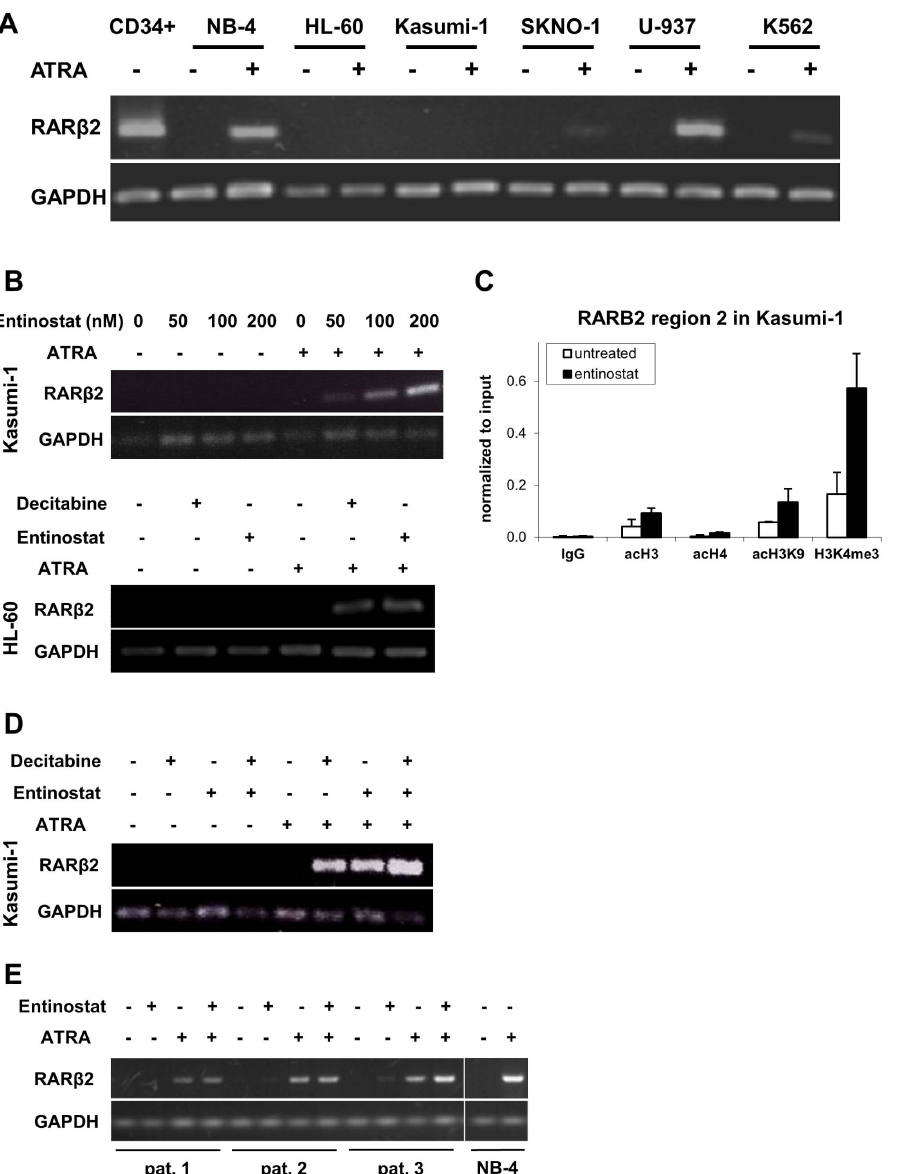
Figure 3. Epigenetic RAR b 2 gene silencing in myeloid leukemia cells is reversed by epigenetically active drugs. ( A ) The AML cell lines NB-4, HL-60, Kasumi-1, SKNO-1 and U-937 as well as the CML cell line K562 were treated with 1 m M ATRA for 72 hours, and expression of RAR b 2 was determined by RT-PCR. The expected band of 621 bp corresponding to the RAR b 2 isoform is shown. Normal CD34 + cells were used as a positive control for RAR b 2 mRNA expression. GAPDH served as a control for equal amounts of RNA. ( B ) Effect of entinostat, alone or in combination with decitabine or ATRA, on RAR b 2 expression in Kasumi-1 and HL-60 cells. Upper panel, Kasumi-1 cells were treated as described in Materials and Methods with entinostat and ATRA (1 m M) at the concentrations indicated. RAR b 2 and GAPDH (internal control) mRNA levels were assayed using RT-PCR. Lower panel, HL-60 cells were treated with ATRA (1 m M), decitabine (200 nM) and entinostat (500 nM) as described above. Cells were then subjected to RT- PCR as described. ( C ) Effect of entinostat on chromatin structure in the RAR b 2 gene region 2 in Kasumi-1 cells. Cells were treated with 1 m M entinostat for 24 hours, chromatin immunoprecipitation was performed for the indicated chromatin marks, followed by quantitative real-time PCR for precipitated DNA using primers specific for RAR b 2 region 2 (RARE element, see Materials and Methods). ( D ) Cooperative effects of decitabine and entinostat upon RAR b 2 re-induction. Kasumi-1 cells were treated with ATRA (1 m M), decitabine (50 nM) and entinostat (50 nM) as shown in Fig. 1A and B. Expression of RAR b 2 and GAPDH mRNAs was determined by RT-PCR. ( E ) Effect of entinostat or ATRA, alone or in combination, on RAR b 2 expression in primary AML blasts. Primary AML samples were treated with entinostat and ATRA ex vivo as described in Materials and Methods. RAR b 2 and GAPDH (internal control) mRNA levels were assayed using